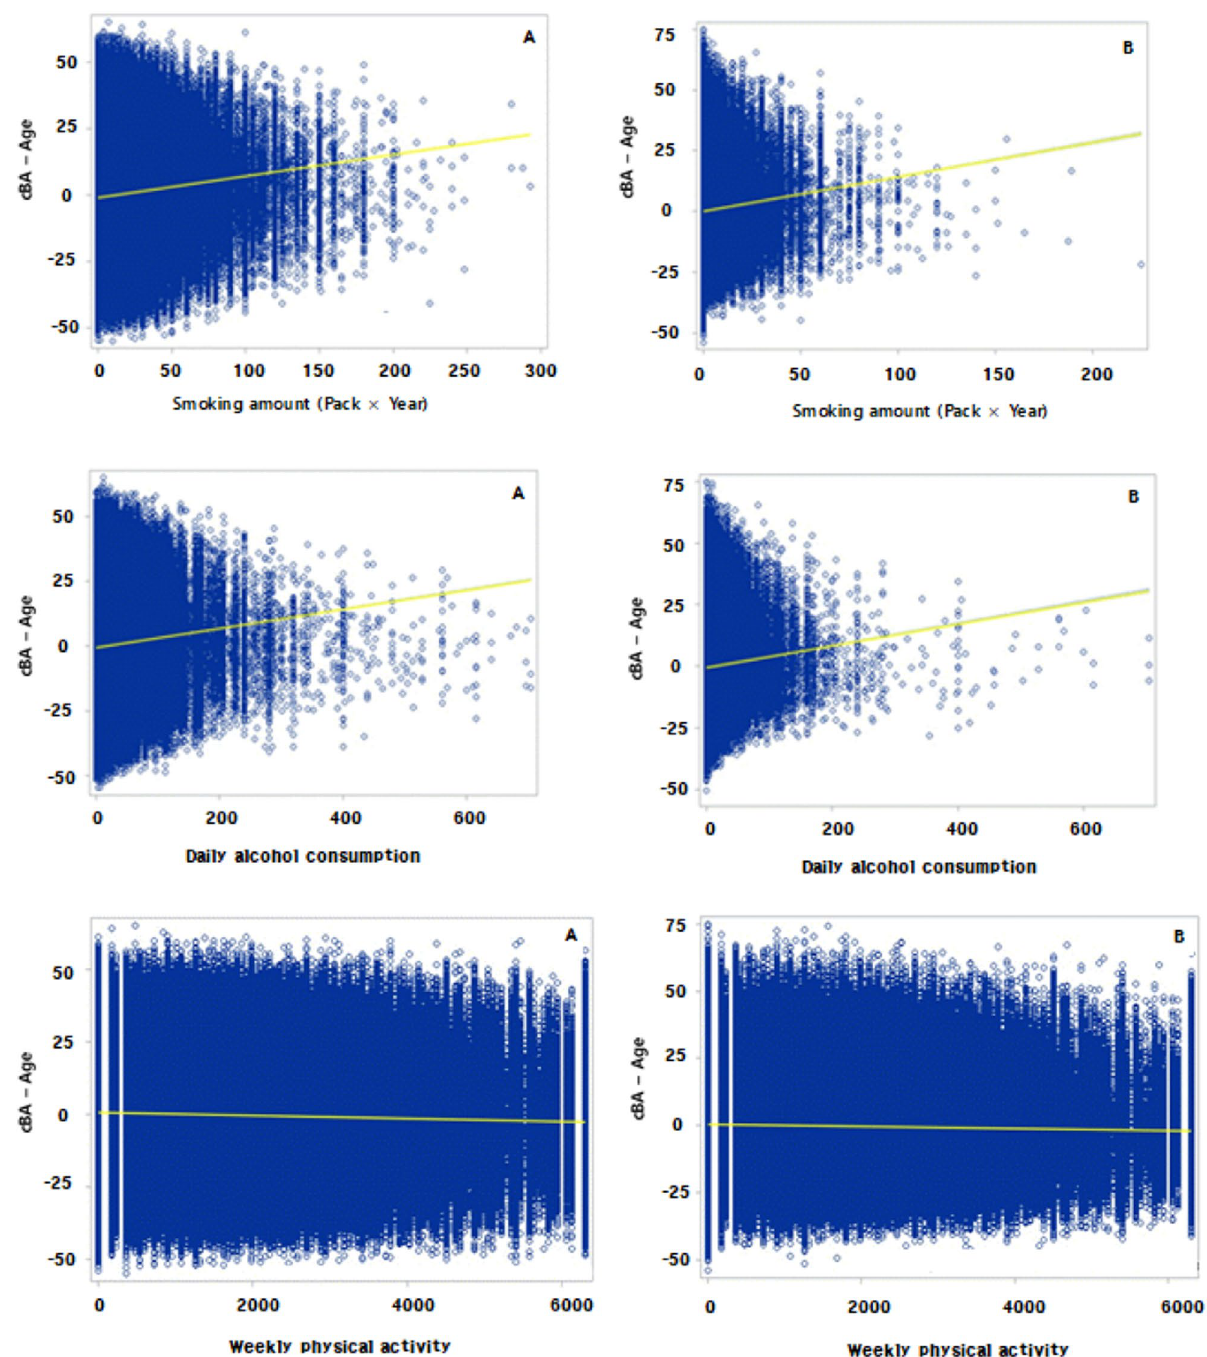
Figure 3. Relationships between lifestyle factors and MS BA ( A : Male, B :